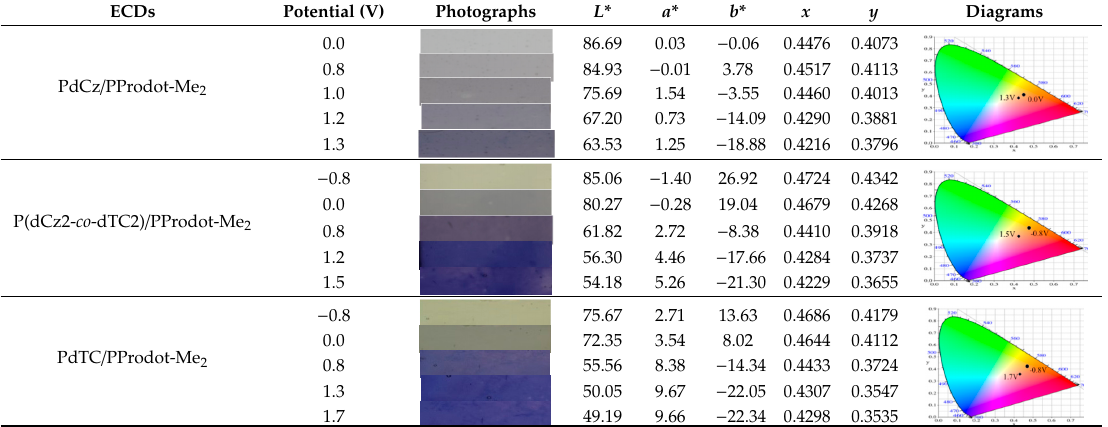
Diagrams Diagrams